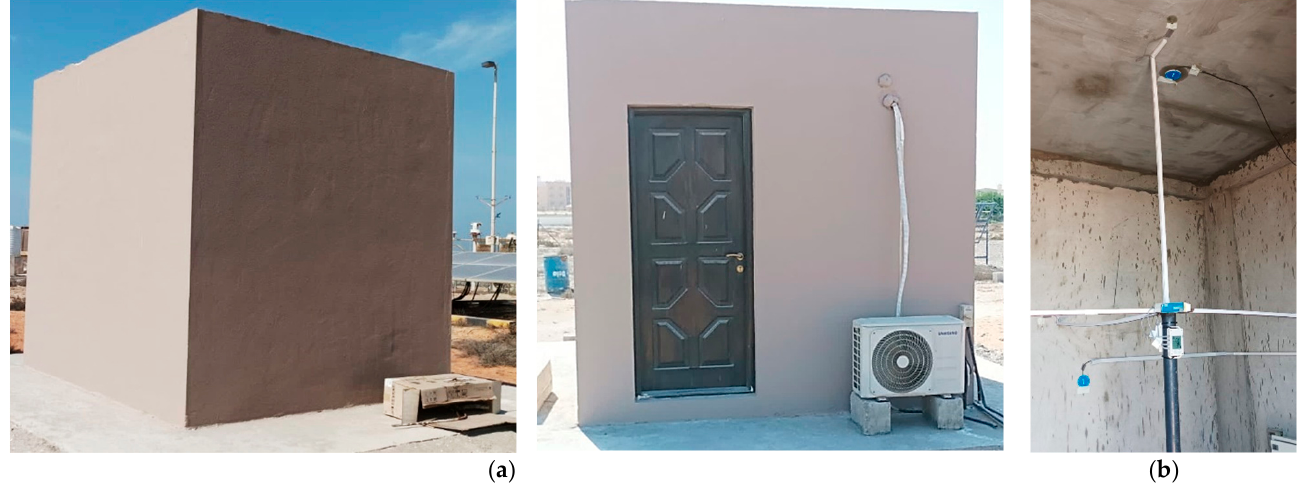
Figure 11. Pictures showing the exterior and interior of the pilot test cubicles. ( a ) Test cubicle. ( b ) Interior of the cubicles.